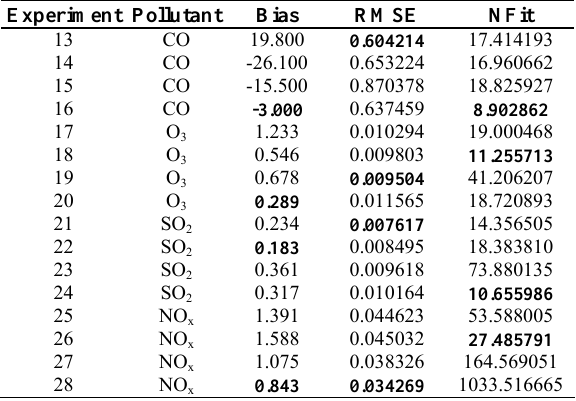
Table 7. Experimental results of the second generation